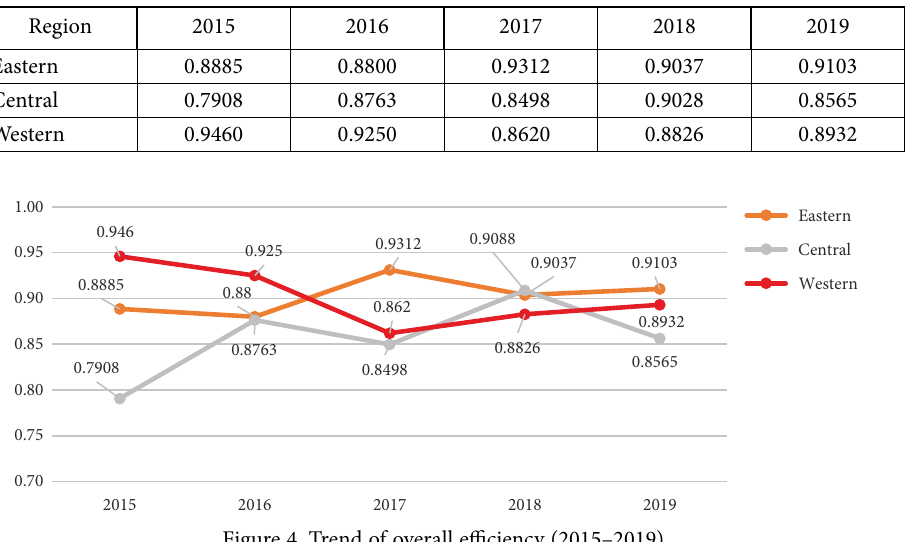
Figure 4. Trend of overall